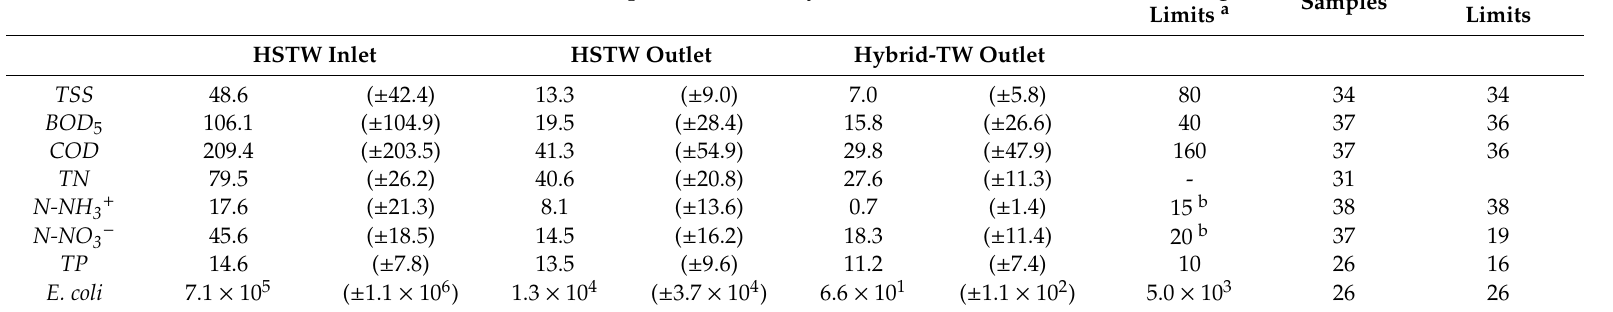
Note: TSS , total suspended solids (mg L − 1 ); BOD 5 , biological oxygen demand after five days (mg L − 1 ); COD , chemical oxygen demand (mg L − 1 ); PO 4 , phosphate (mg L − 1 ); TN , total nitrogen (mg L − 1 ); N-NH